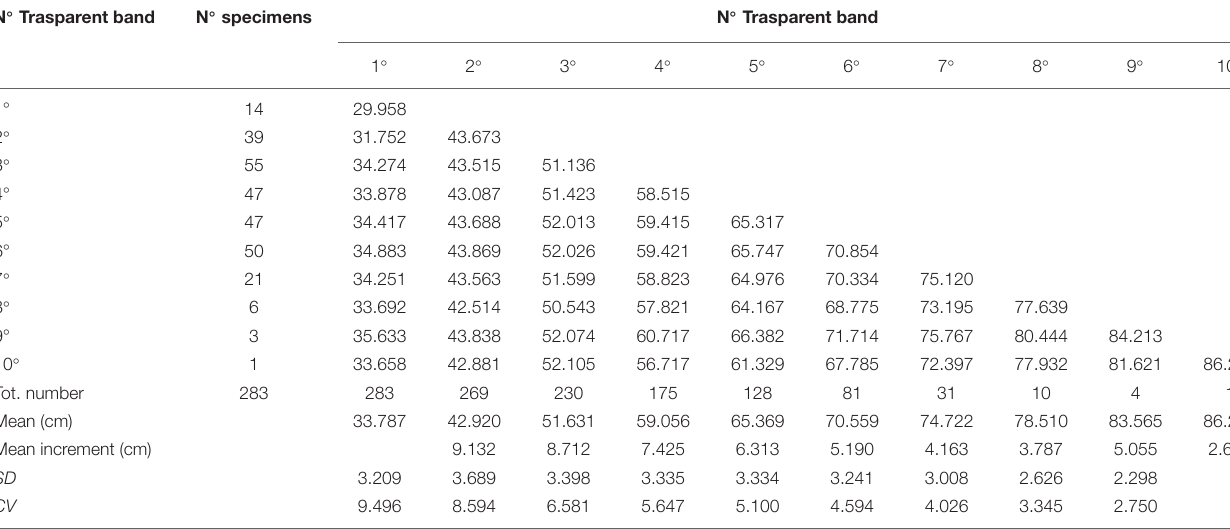
TABLE 3 | Mean back-calculated length for each transparent band.